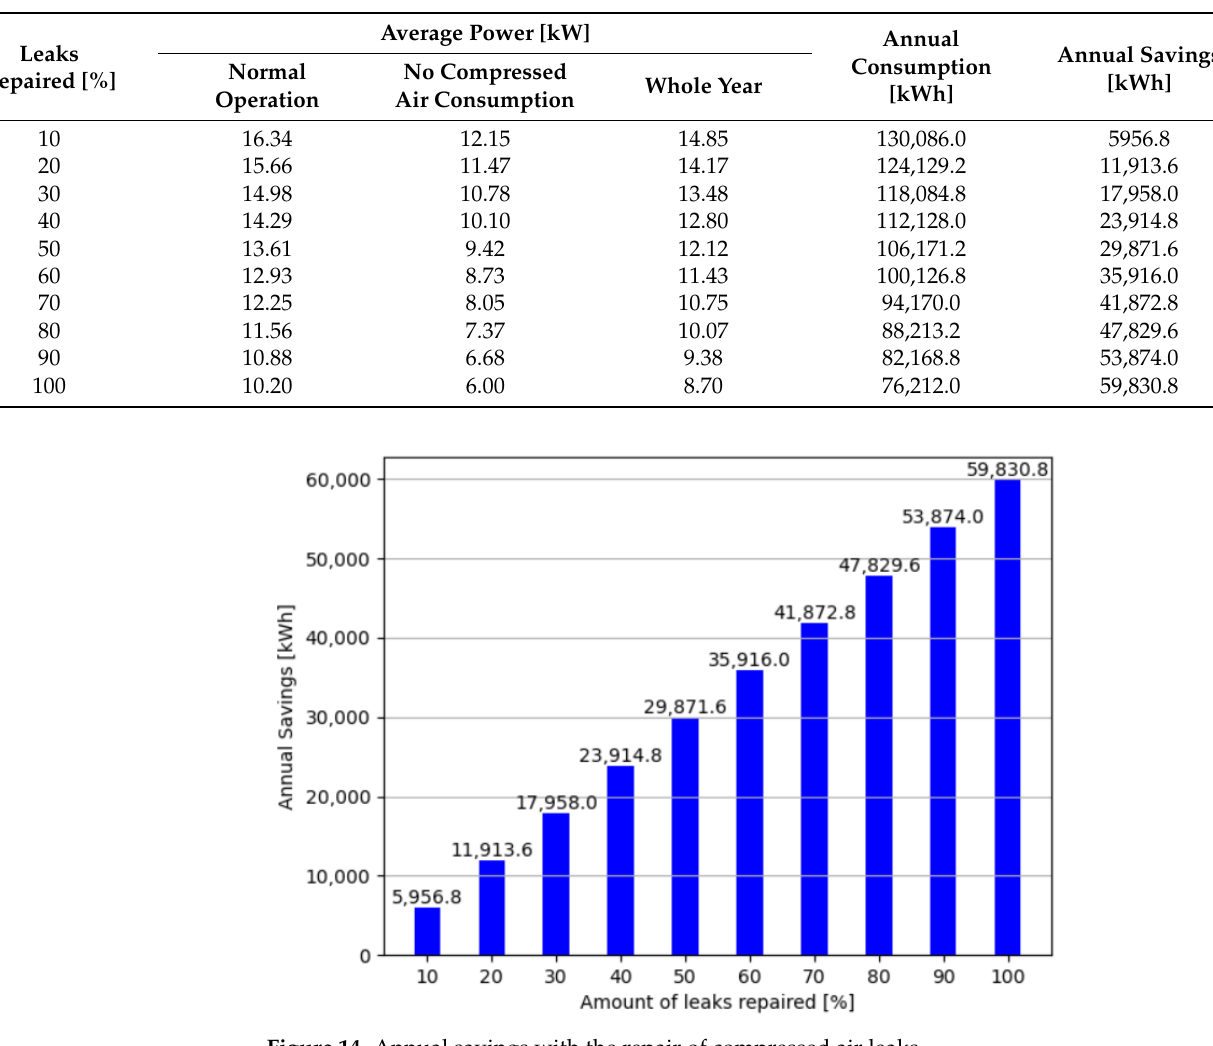
Figure 14. Annual savings with the repair of compressed air leaks.